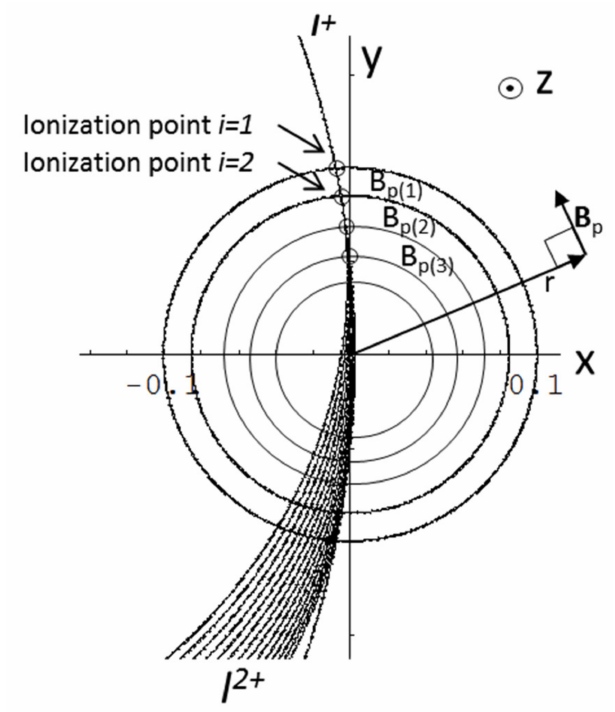
Figure 16. Ion trajectories assuming cylindrical geometry for the plasma